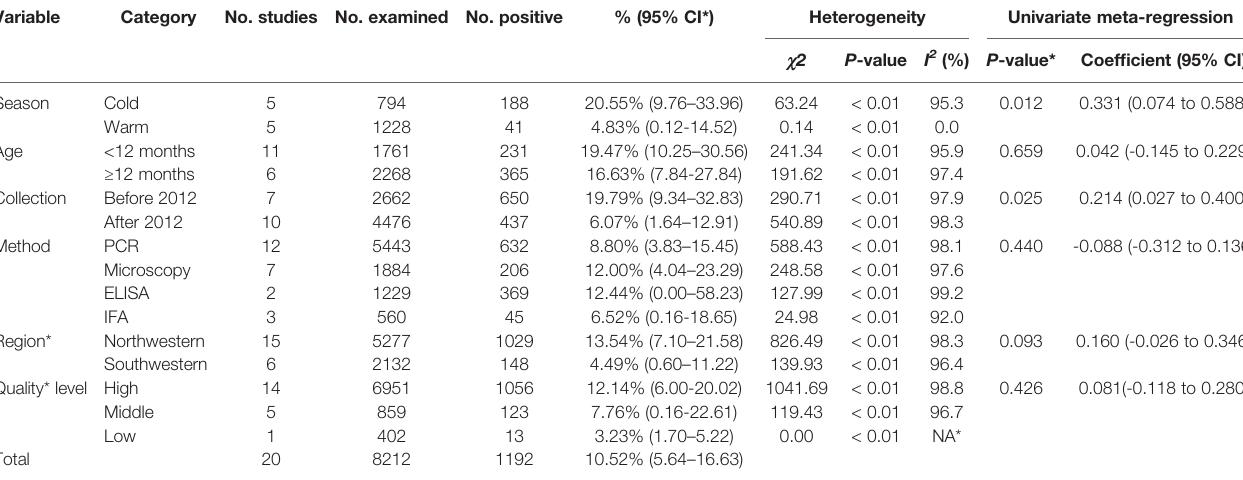
TABLE 2 | Pooled prevalence o f Cryptosporidium infection in yaks in China. Variable